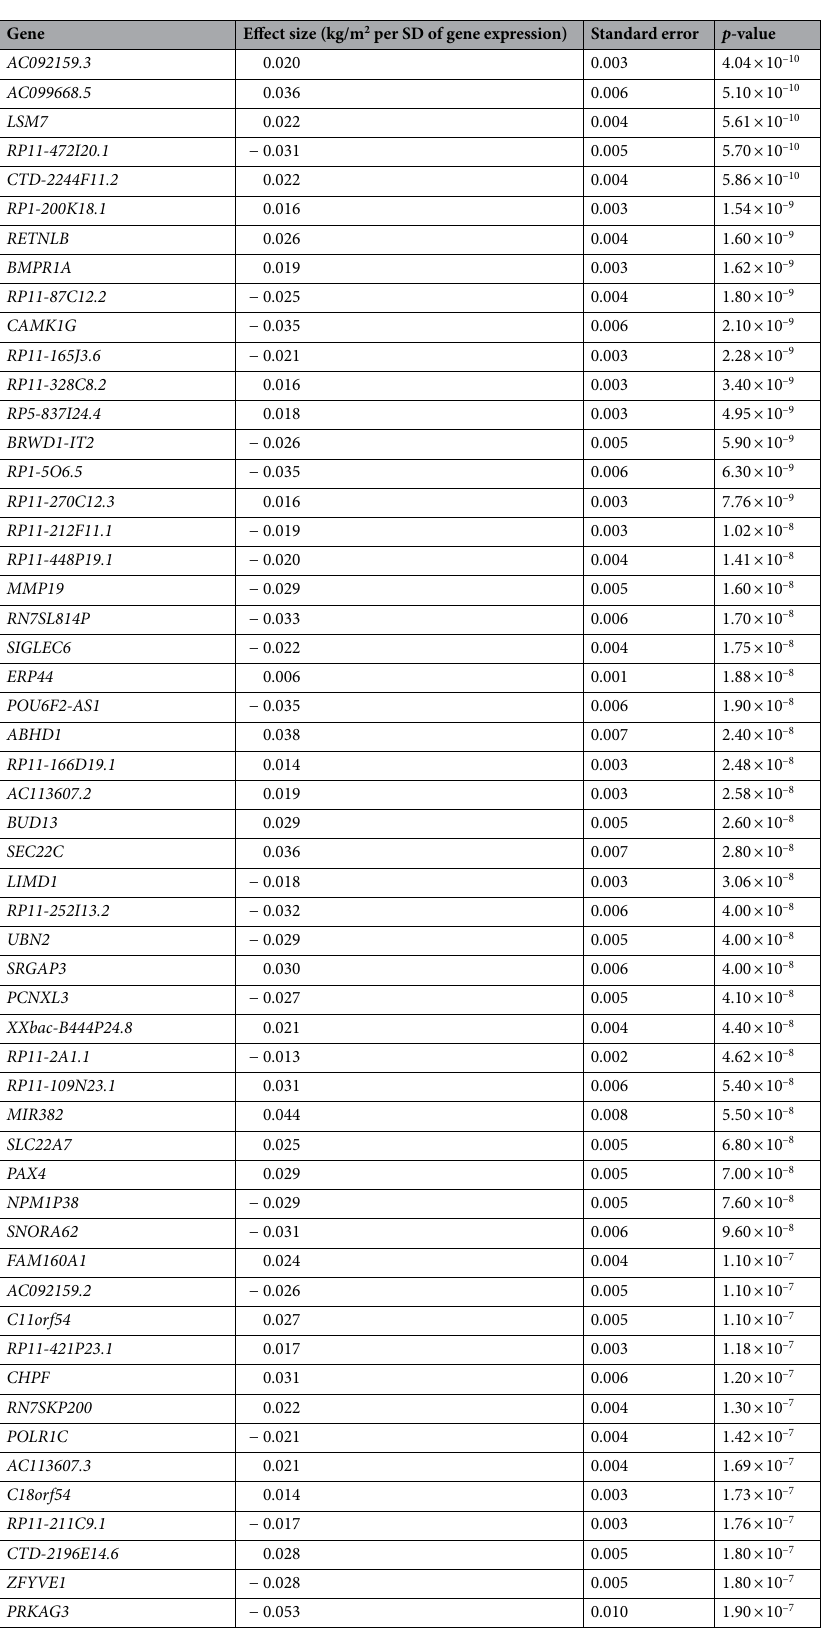
Table 2. Genes where expression was significant exclusively in the placenta for adult